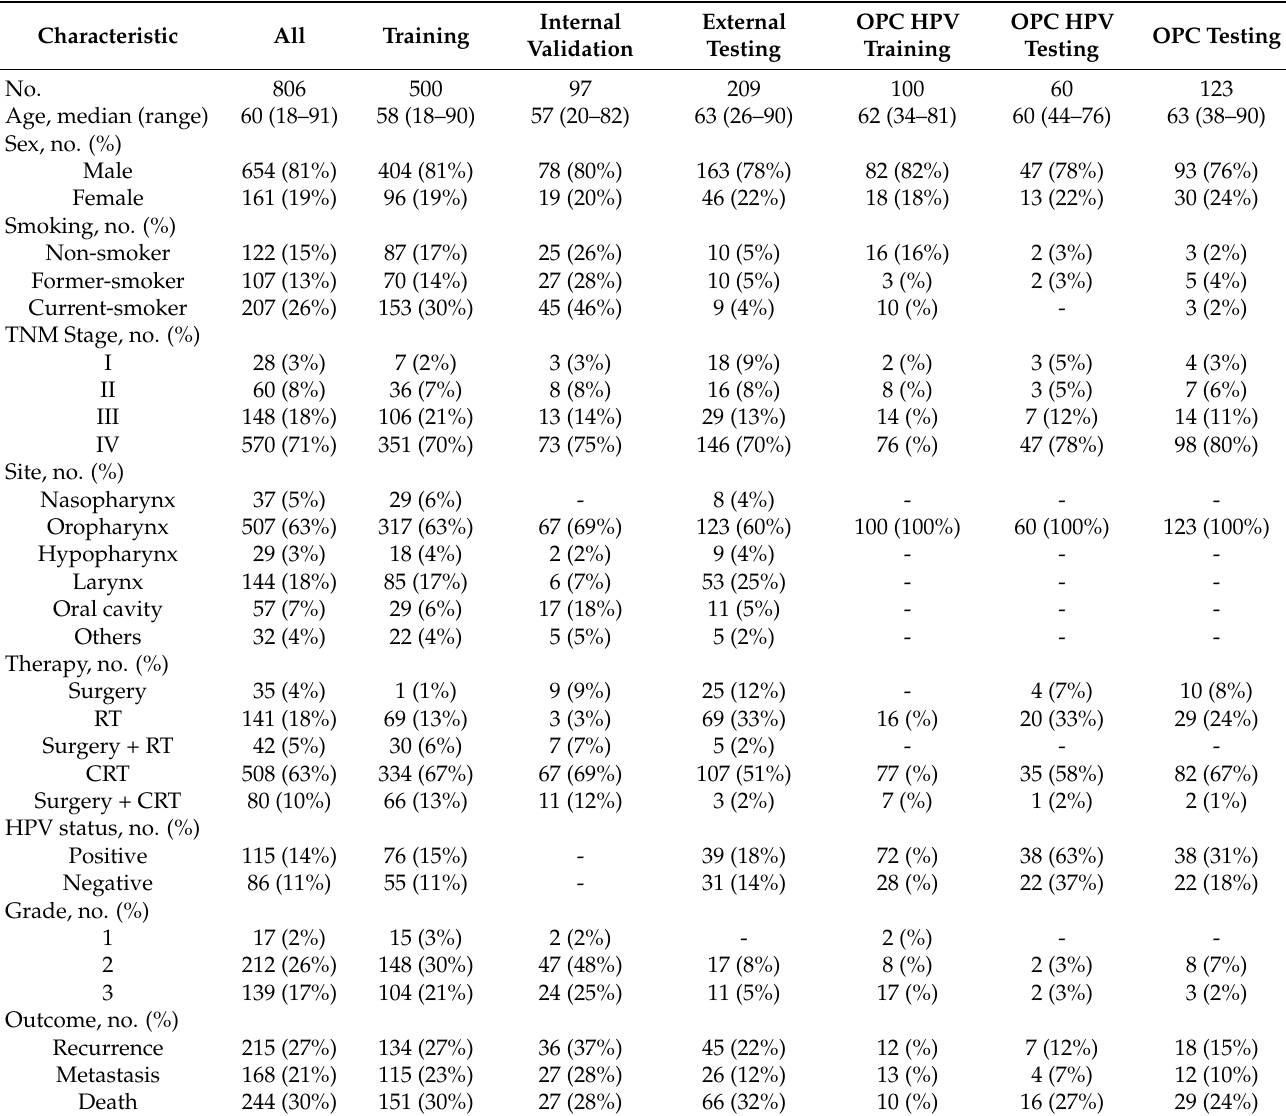
Table 1. Clinical characteristics of the HNC patients in training ( n = 500), internal validation ( n = 97), and external testing ( n = 209) cohorts. There are 123 patients from external testing cohort with OPC (OPC testing), and amongst them, 60 patients had HPV status (OPC HPV testing). Furthermore, 100 OPC patients from the training cohort had HPV status (OPC HPV